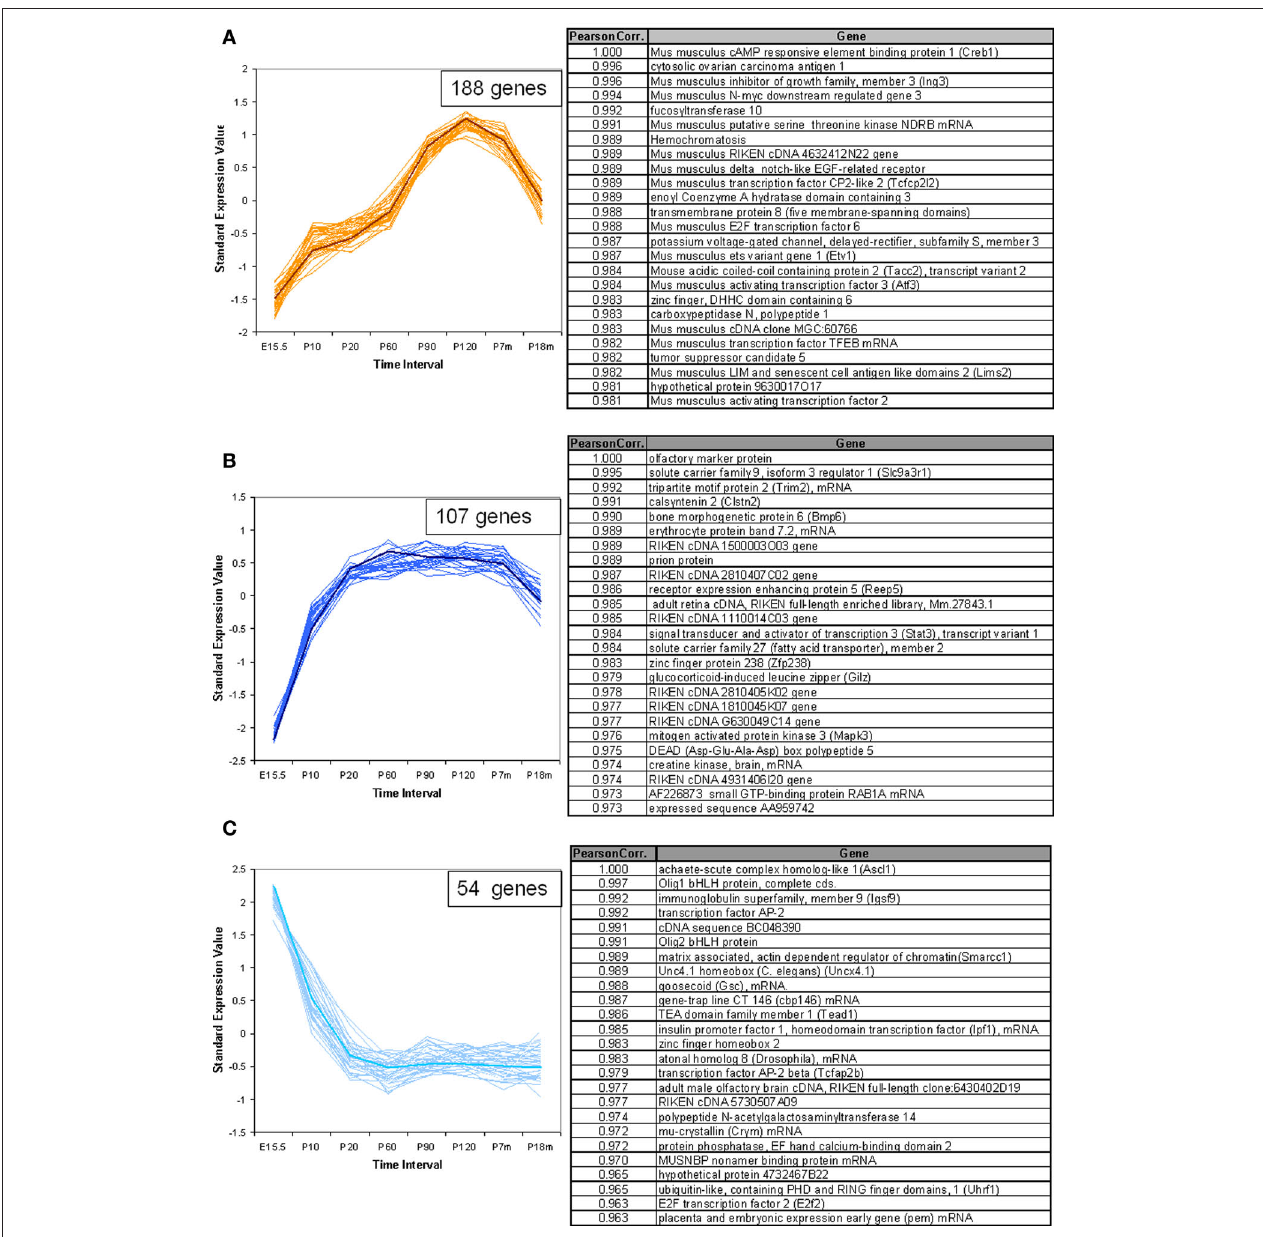
categorized in regulation of cellular metabolism in Gene Ontology with p -value < 0.0001. (B) This pattern was composed of 107 genes, with the olfactory marker protein as the representative gene. Genes in this pattern showed a plateau between P20 and P210, followed by a slight decrease at P550. (C) 54 genes followed into this pattern, with Ascl1 (with synonym of Mash1) as the typical gene. This pattern showed an obviously high expression level at embryonic age and a slope after birth. After P20, a low expression level was maintained. Together with Mash1, Olig1, were proved to be important for neuron differentiation from progenitor cells to different cell types. Genes in this pattern were significantly categorized in DNA-binding transcription regulation in Gene